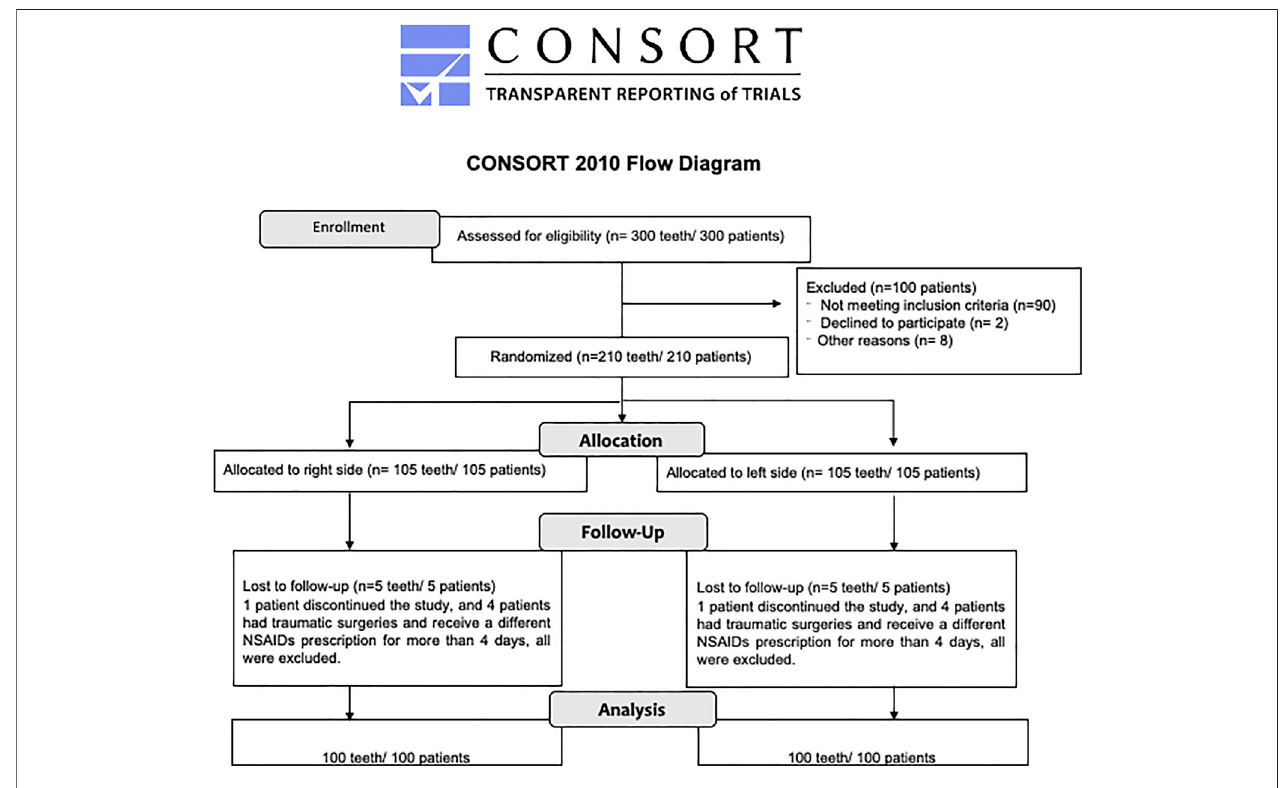
FIGURE 1 | Consort fl ow diagram (Weckwerth et al.,